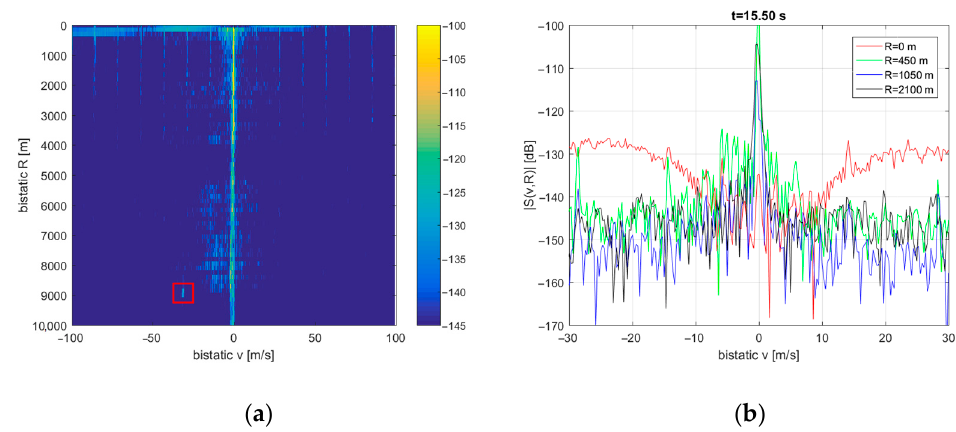
Figure 13. Clutter image during the storm ( a ) and its cross-sections for selected bistatic ranges ( b ).